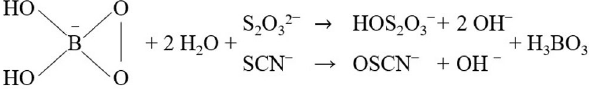
Table 1 . Step R2 produces, while step R3 consumes H + with